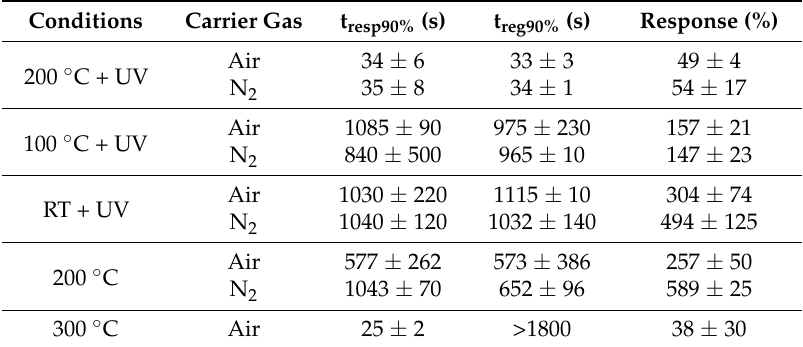
Table 1. Summary of average values of sensors: response times (t resp90% ), regeneration times (t reg90% ) and responses to 1 ppm of NO 2 at different